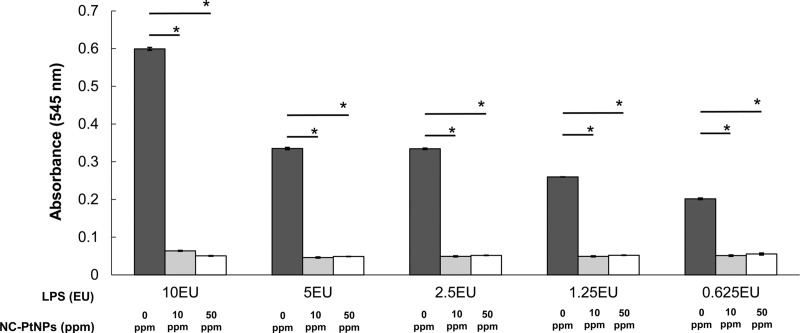
Functional potential of nanoplatinum solutions to decompose LPS.Overall, 10 and 50 ppm PtNPs were added to LPS at different concentrations and allowed to react for 10 minutes. LPS decreased in all groups. (* p < 0.05, Tukey’s test).